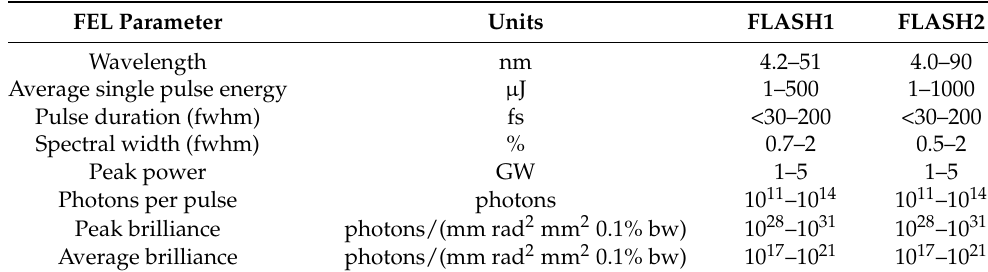
Table 1. FLASH FEL radiation parameters available as of 2021.